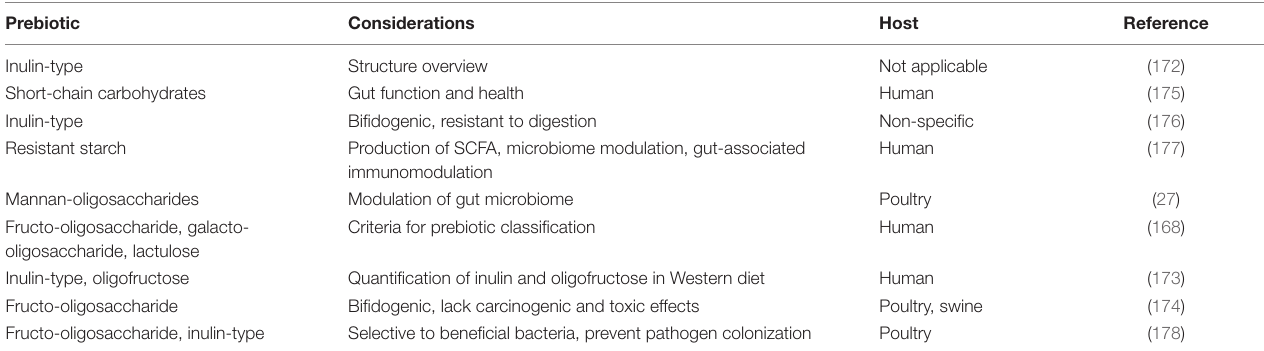
TABLe 4 | Published reviews on the considerations of common prebiotics in various hosts.